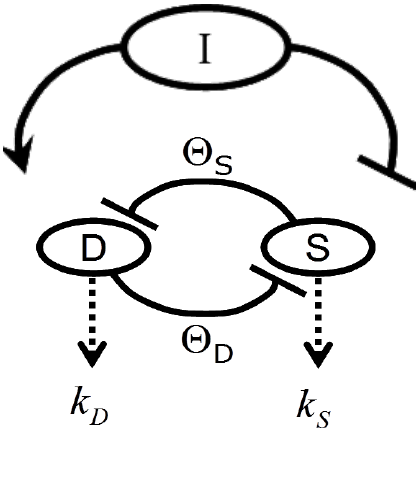
Figure 2. Circuit diagram of the nonlinear dynamical model of cell injury. See text for